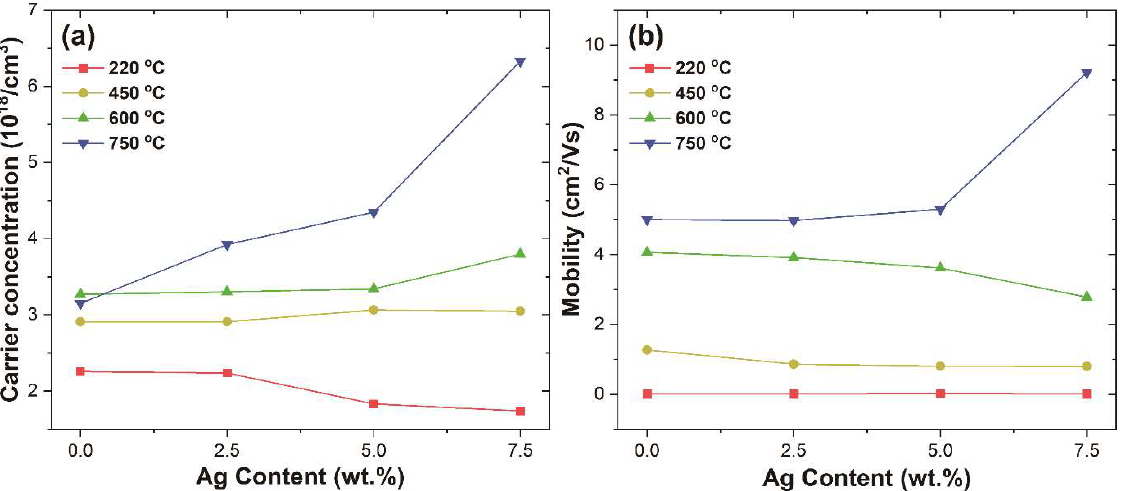
Figure 8. ( a ) Carrier concentration and ( b ) mobility of ITO and ITO@Ag thin films according to the silver weight percentage and thermal-treatment temperature.